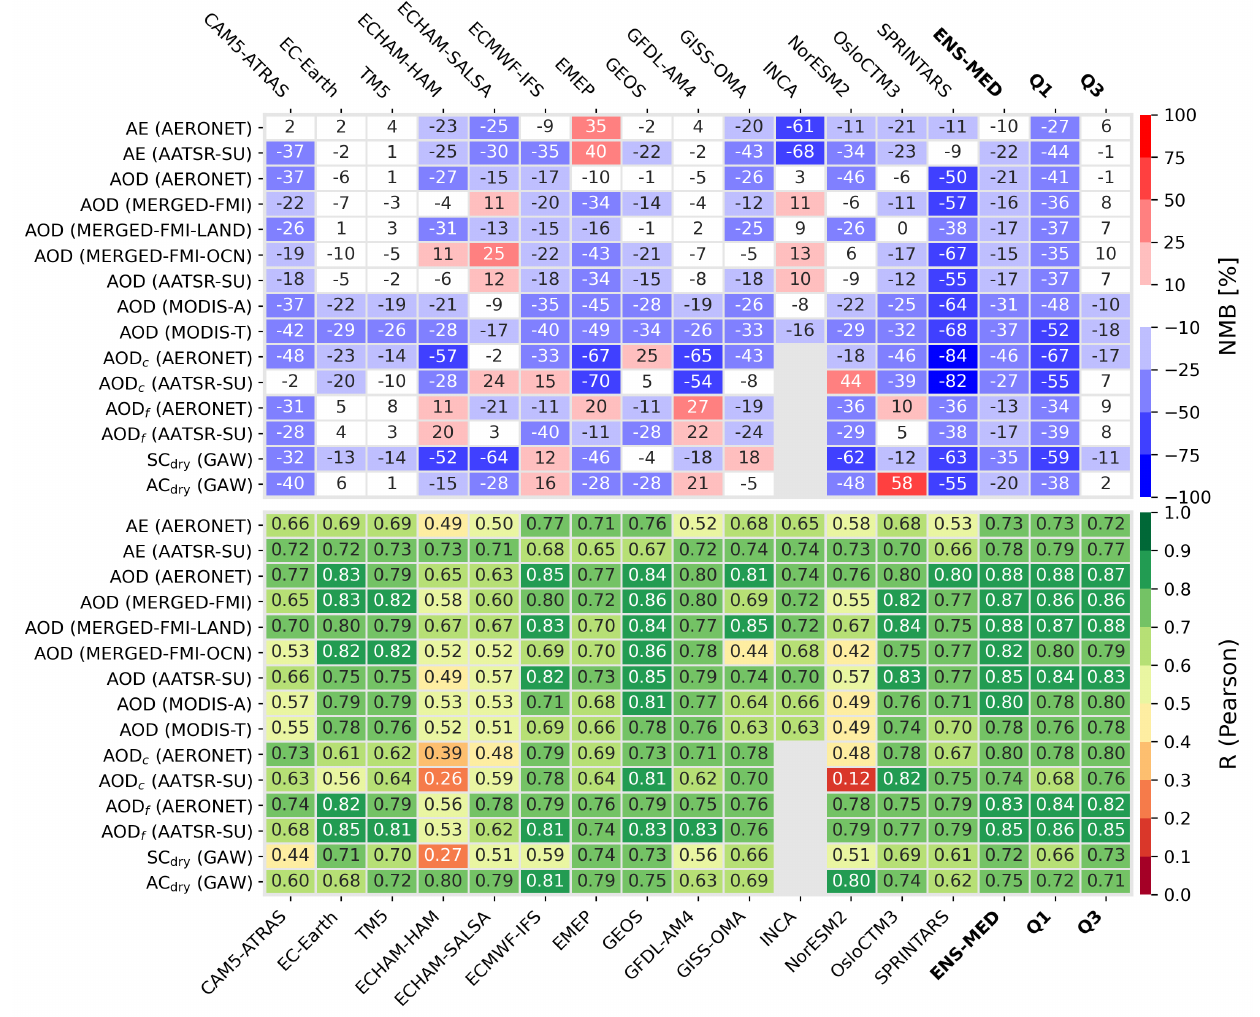
Table 4. Normalised mean bias (NMB; top) and Pearson correlation coefficients ( R ; bottom), computed from the monthly co-located data for each model (columns) and observation/variable combination (rows). For the comparison with the gridded 5 ◦ × 5 ◦ satellite products, area weights were applied to compute the average metrics shown here. Please note that the biases do not represent global averages but the site/sampling locations of each data set, with more weight given to regions with higher spatial density (e.g. Fig. 1). Please also note potential offsets in the absolute biases arising from uncertainties in the observation retrievals, particularly for the satellite products (see Table 1). The rightmost columns show evaluation results from the ensemble median (ENS-MED) as well as first and third quantile fields (Q1, Q3). The latter indicate the spread of the results. Model values for AODs are for clear-sky conditions unless only all-sky were